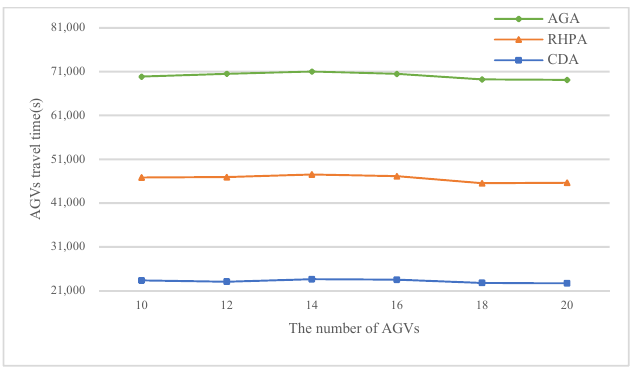
Figure 12. Curve of AGVs travel time with the number of AGVs.